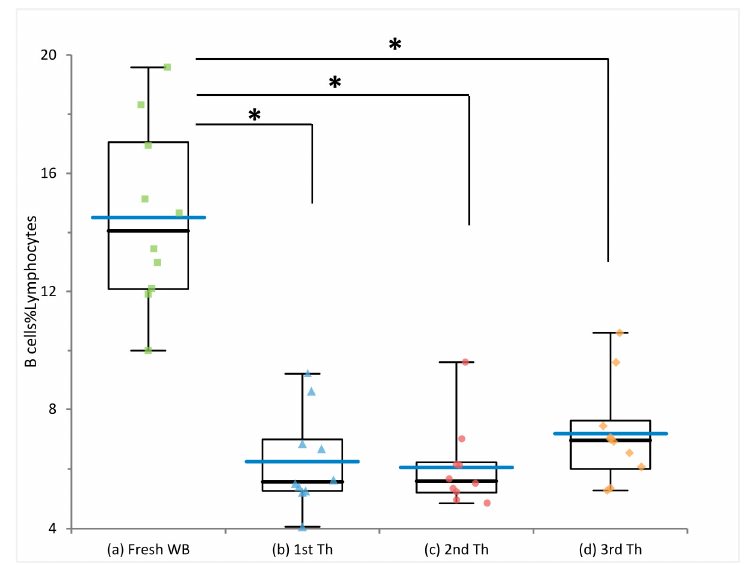
Figure 3. Effect of cryopreservation and multiple freezing cycles on B cell frequency. Comparison of B cell frequency measured in fresh whole blood (WB) and in PBMC subjected to multiple thawing (Th) cycles. * p -values from the paired t -test < 0.05. Blue bars indicate mean